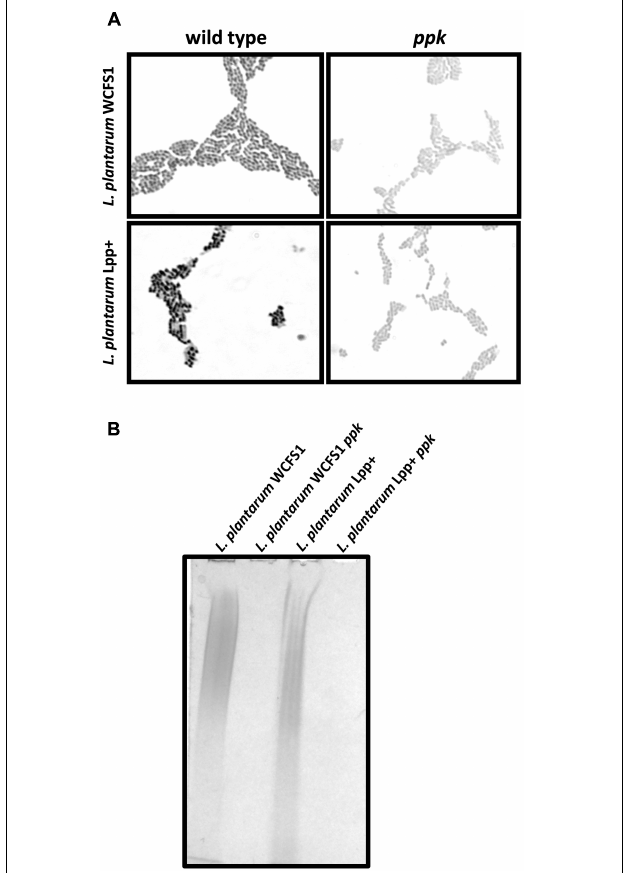
FIGURE 1 | Polyphosphate accumulation in Lactobacillus. (A) Micrographs (100 × ) of Neisser-stained L. plantarum WCFS1 and L. plantarum Lpp+ and their respective ppk -disrupted strains grown on MEI plates. The synthesis of poly-P in the wild-type strains is evidenced by the formation of dark cytoplasmic granules revealed by the specific staining. (B) Polyacrylamide-urea gel electrophoresis of poly-P isolated from different strain. The gels were stained with toluidine